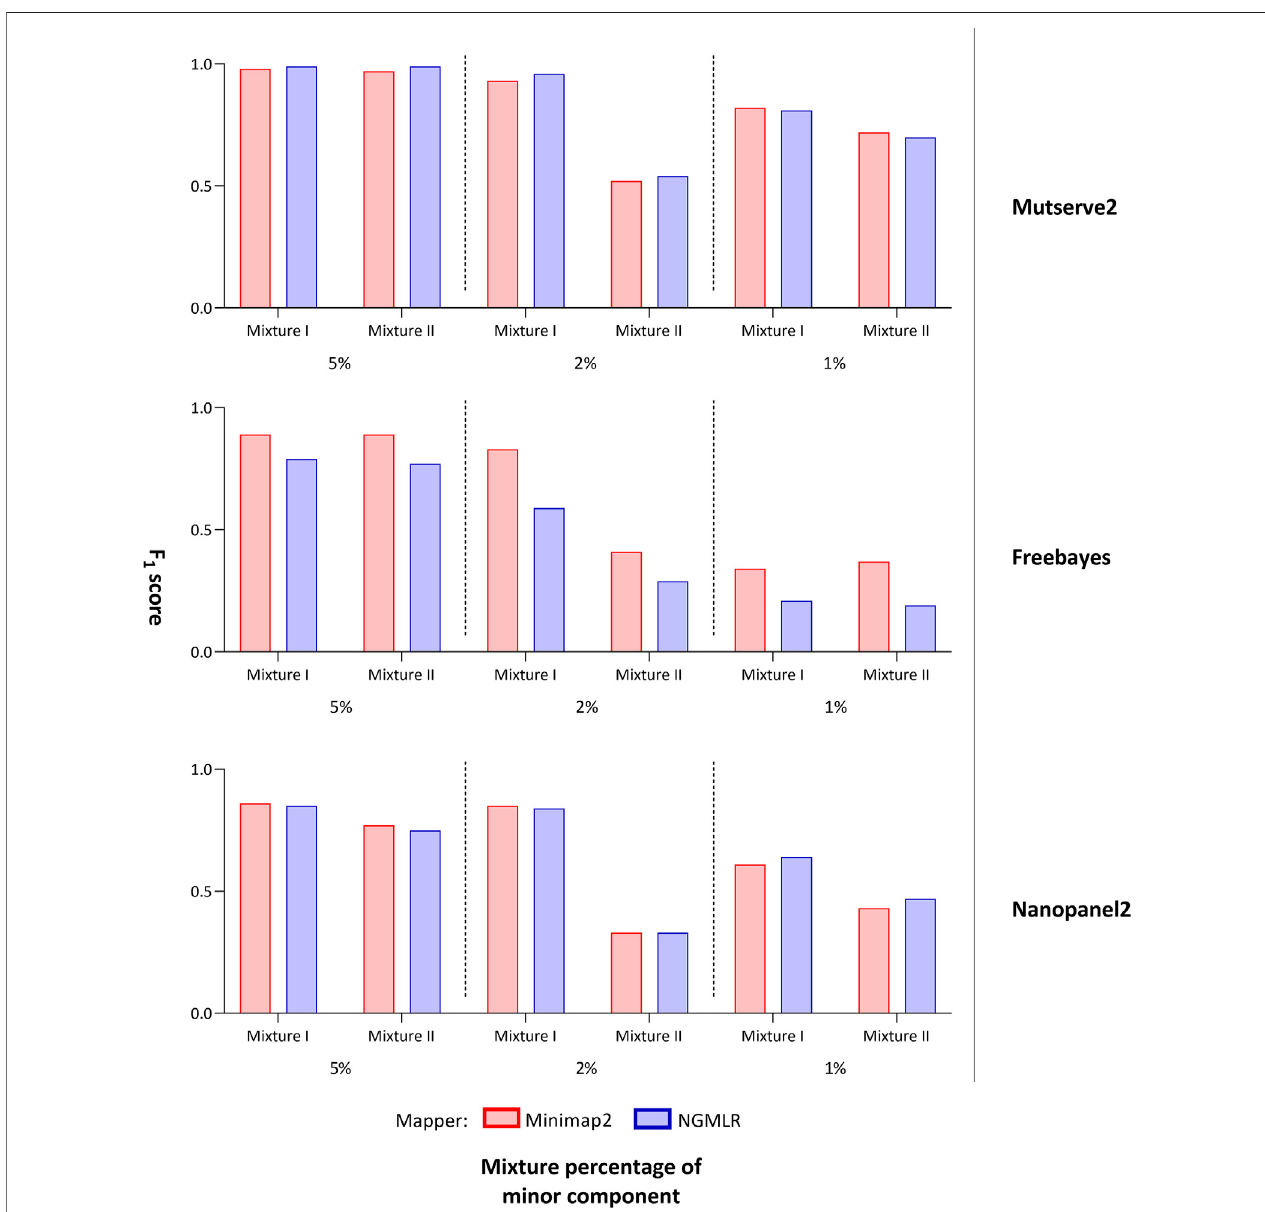
FIGURE 2 | F 1 score of tested variant callers. Bar chart that shows the F 1 score of the mitochondrial variants detected with two aligners (i.e., Minimap2 and Ngmlr) and the three variant callers (i.e., Mutserve2, Freebayes, and